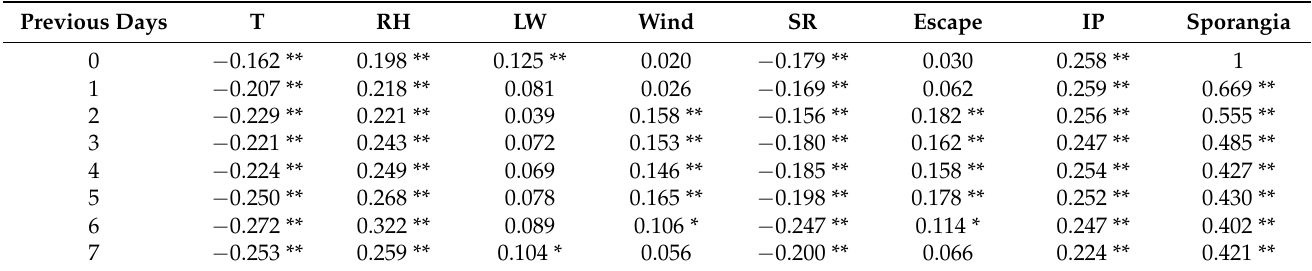
Table 4. Spearman correlation coefficients between daily weather parameters and sporangia concen- tration until seven previous days.